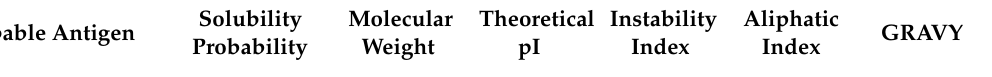
Table 6. Allergenicity, antigenicity, solubility and physio-chemical properties of predicted 16 vaccine constructs. (Negative values in red fonts were not considered